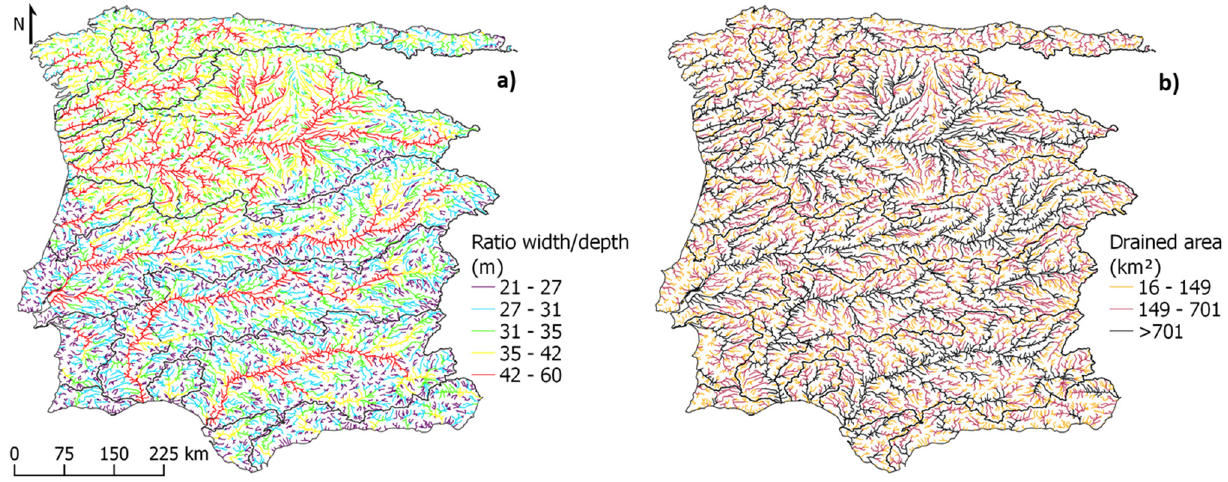
Figure 7. Ratio between cross-sections width and depth ( a ) and the drained area ( b ) in the studied domain, according to [72].